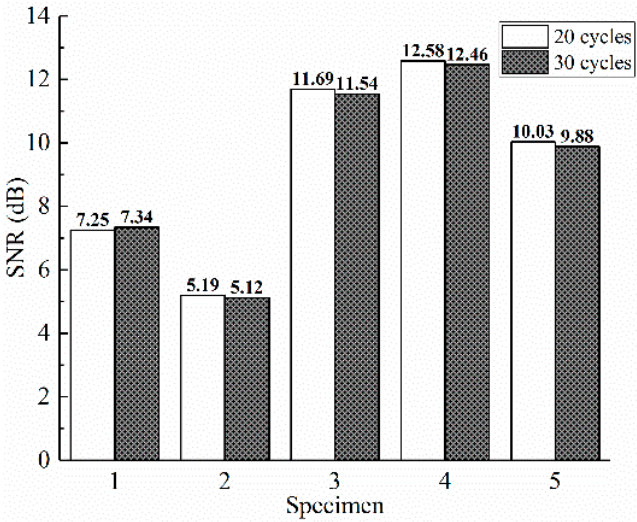
Figure 7. Testing results for cycle numbers on different specimens.